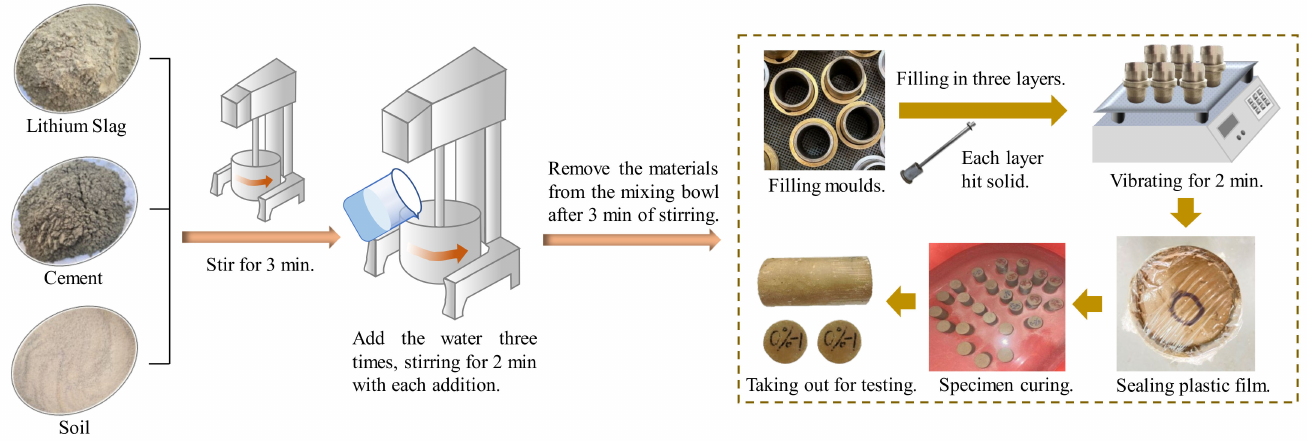
Figure 3. The preparation flow chart of test